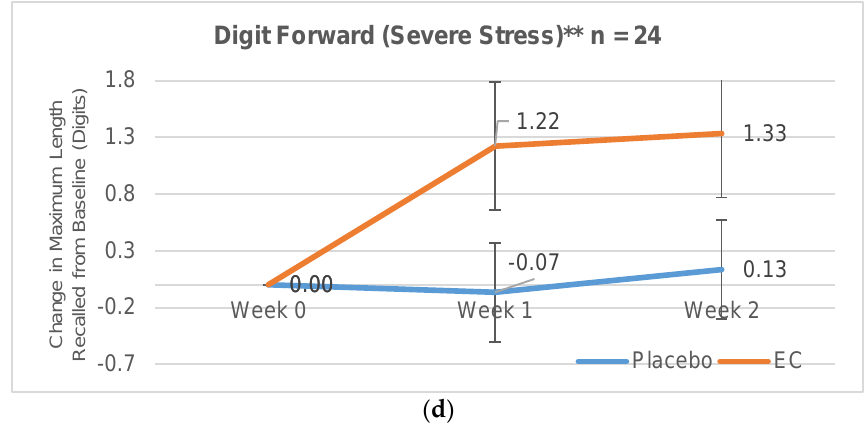
Figure 2. ( a – d ) Estimated Change in Maximum Length of Digits Recalled (±standard error) on the Digit Span Forward by Stress Subgroups at Week 1 and Week 2; * Statistically significant two-way (treatment × visit) interaction: p = 0.041; ** p = 0.065.